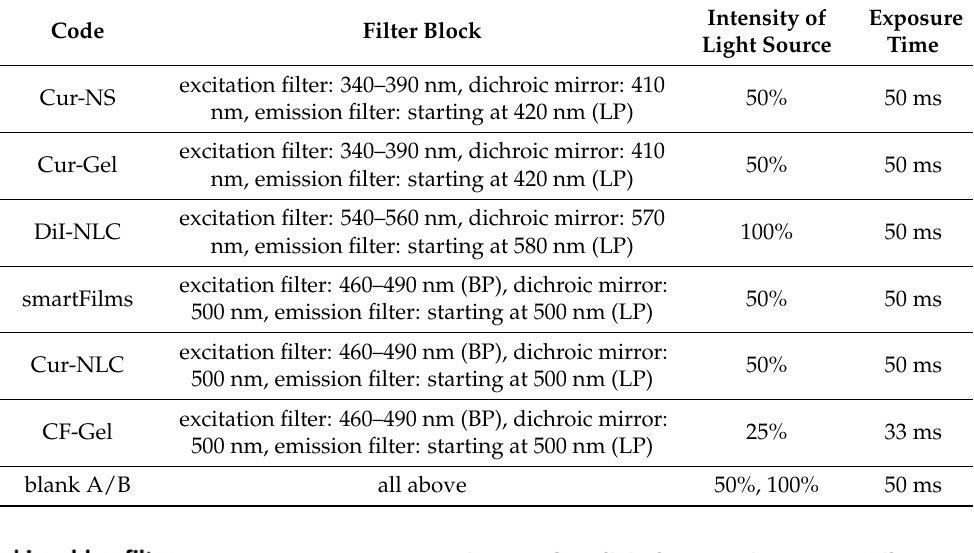
Table 4. Microscopic settings for the different formulations used for image acquisition.